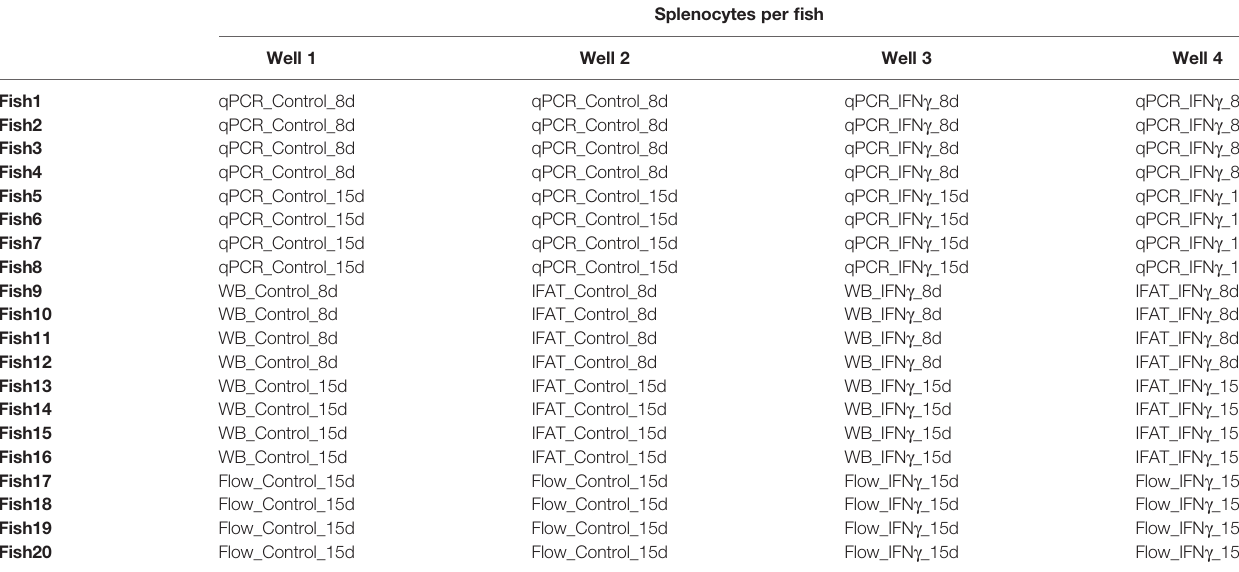
TABLE 1 | Splenocytes distribution by